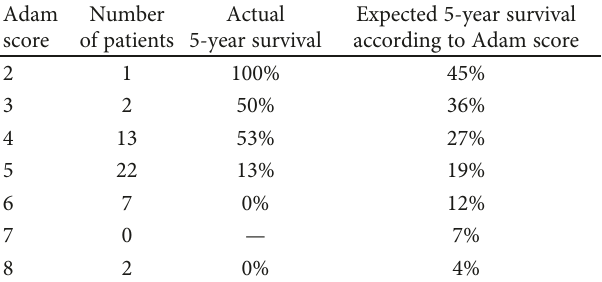
Table 3: Comparison with Adam